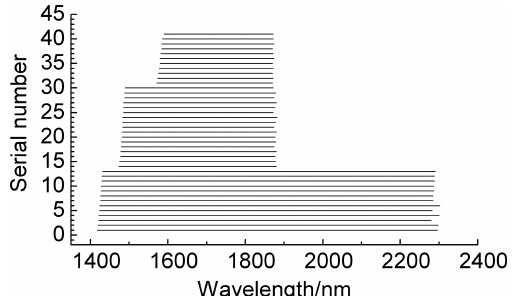
Fig. 6. Position of 41 wavebands in the equivalent model space.